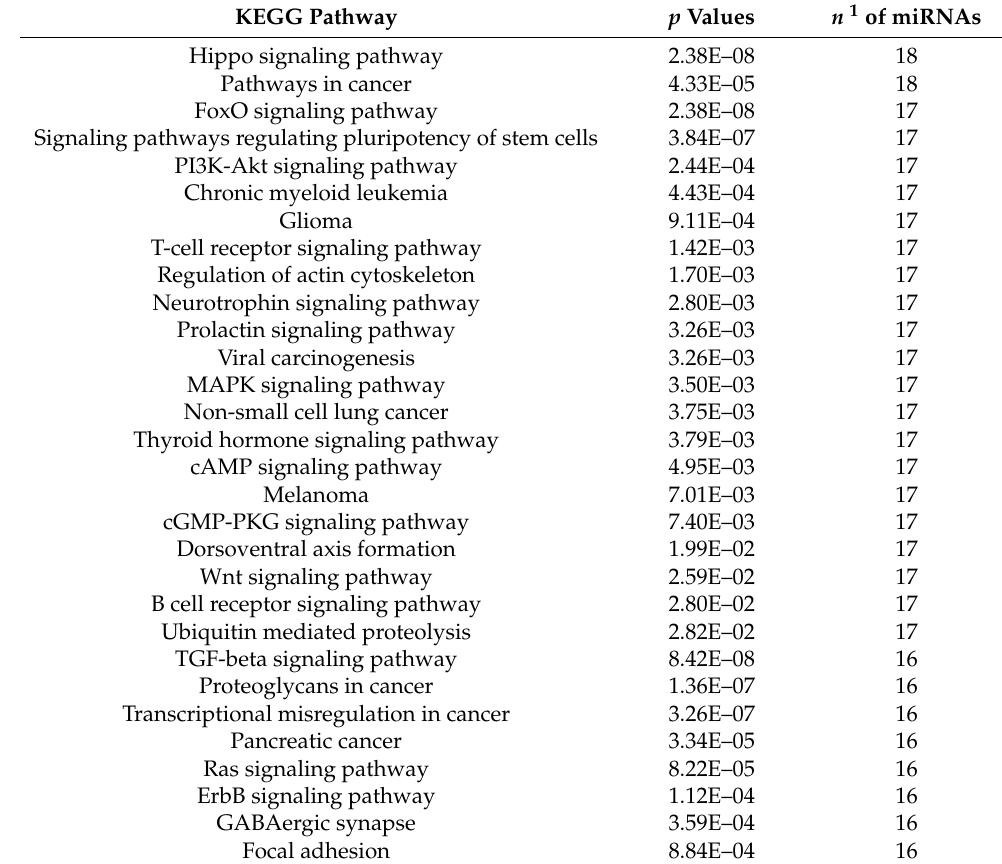
Table 3. Top 30 biological pathways enriched by 19 differentially expressed miRNAs in EGFR -mutated compared to EGFR wild-type lung